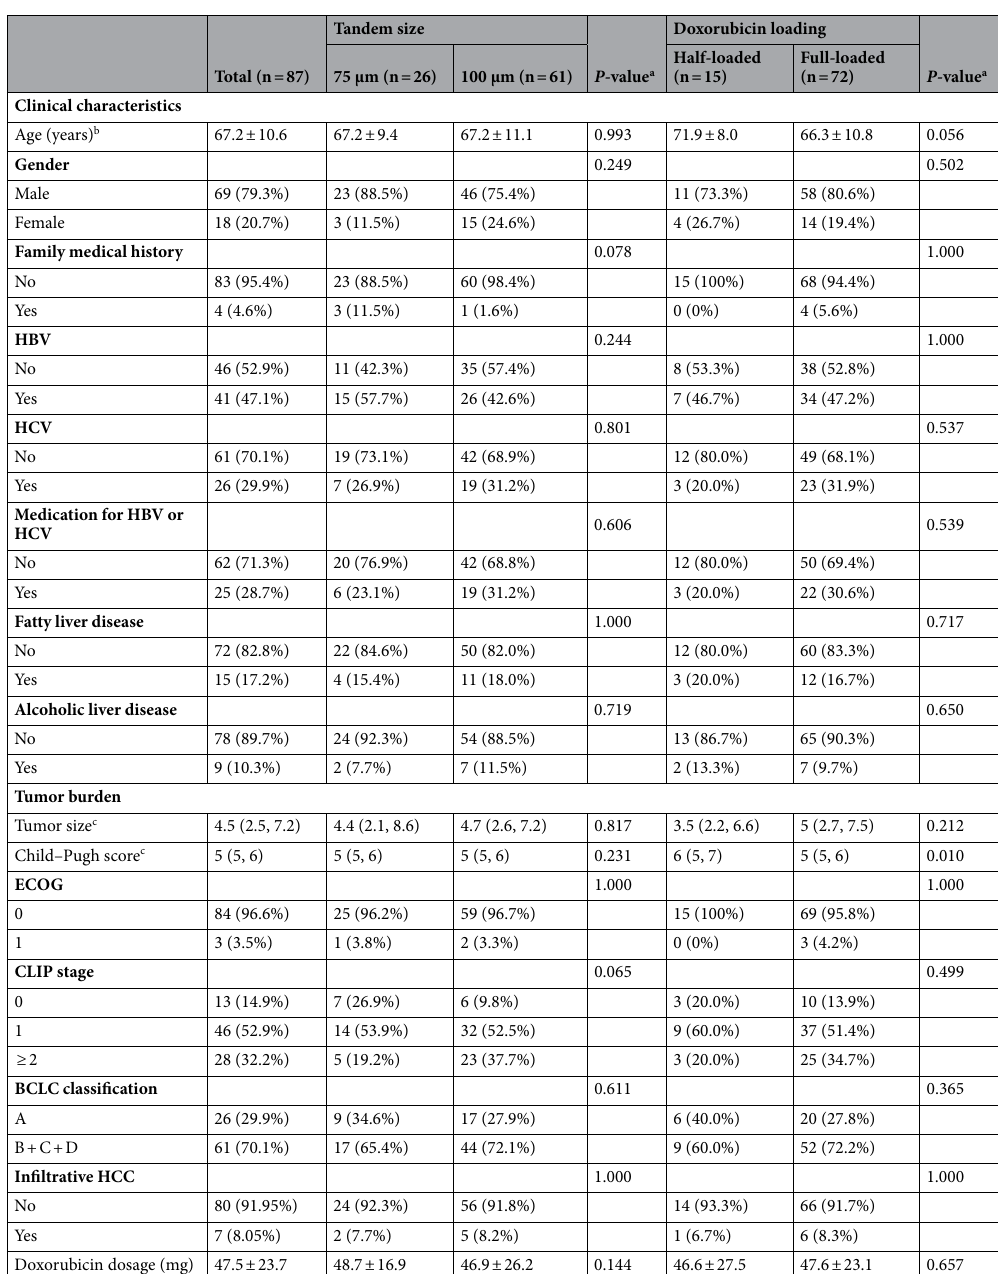
Table 1. Baseline demographics and tumor characteristics of HCC patients. a Mann-Whitney test was used for continuous variables and Fisher’s exact test was used for categorical variables. b Mean ± standard deviation was presented. c Median (inter-quartile range) was presented. Dox doxorubicin, HBV hepatitis B virus, HCV hepatitis C virus, ECOG Eastern Cooperative Oncology Group, CLIP cancer of the liver Italian program, BCLC Barcelona Clinic Liver Cancer, HCC hepatocellular